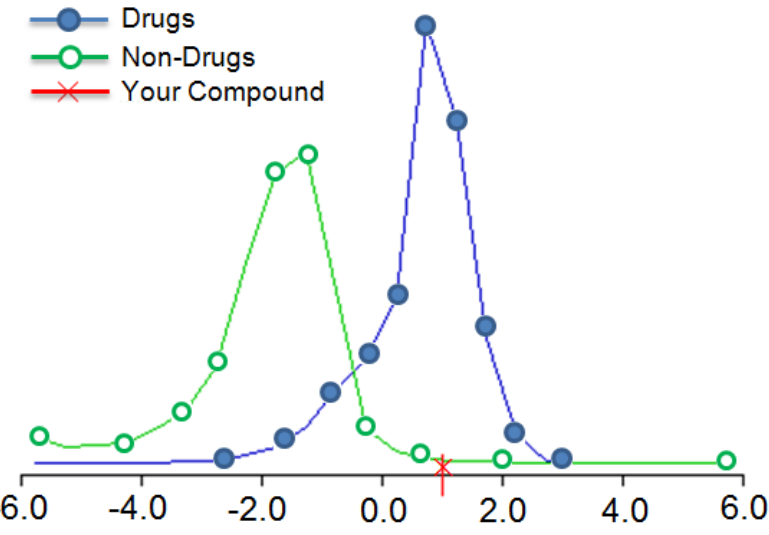
FIGURE 4 - Drug-likeness score model of